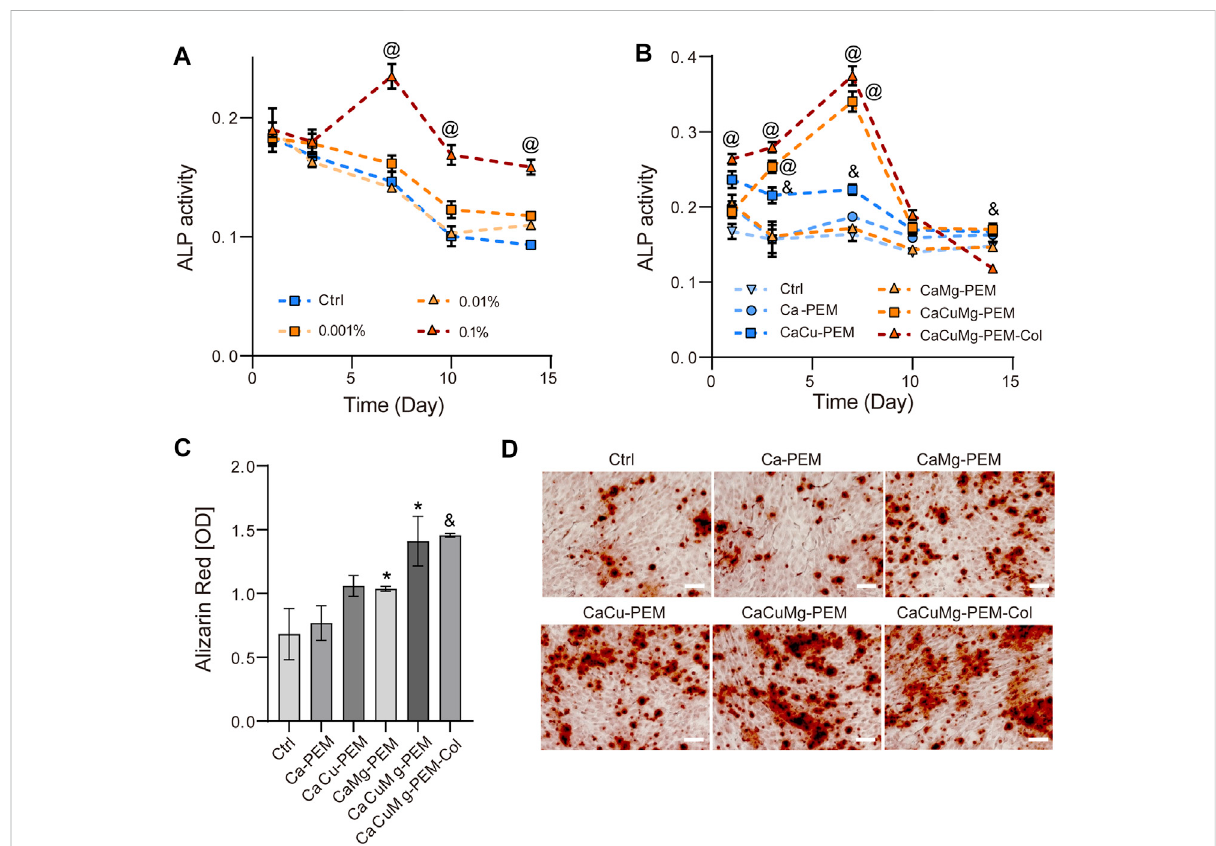
FIGURE 7 ALP activity was evaluated after 1, 3, 7, 10, 14 days with colorimetric method with pNPP as a substrate for ALP: (A) MG63 cells cultured with osteogenic medium supplemented with extract of CaCuMg-PEM-Col microcapsules in different concentrations; (B) MG63 cells cultured with osteogenic medium supplemented with 1% extracts of Ca-PEM, CaCu-PEM, CaMg-PEM, CaCuMg-PEM and CaCuMg-PEM-Col microcapsules. Osteogenic differentiation was revealed by (D) Alizarin Red staining (scale bar = 100 μ m) and (C) quanti fi cation at day 21. ( n = 3; Paired t